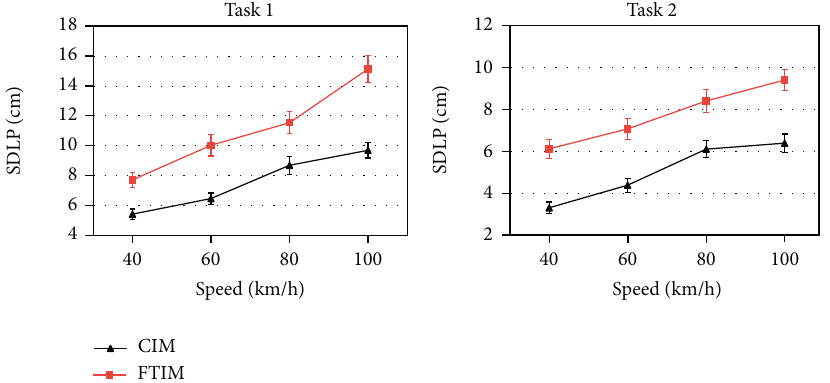
Figure 12: The interaction between interaction mode and speed in SDLP.